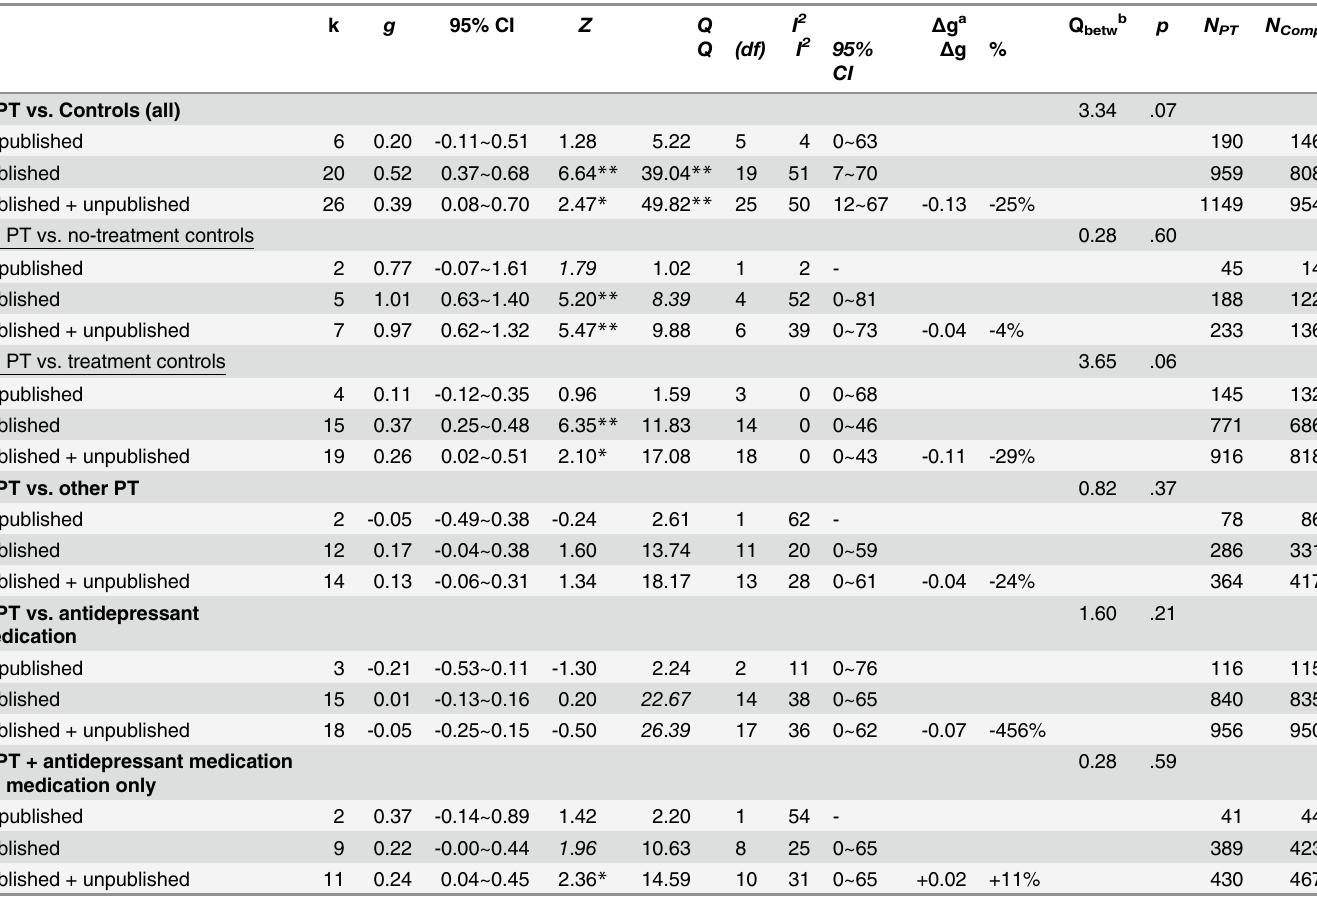
Table 2. Meta-analyses of studies examining the effect of psychological treatment for